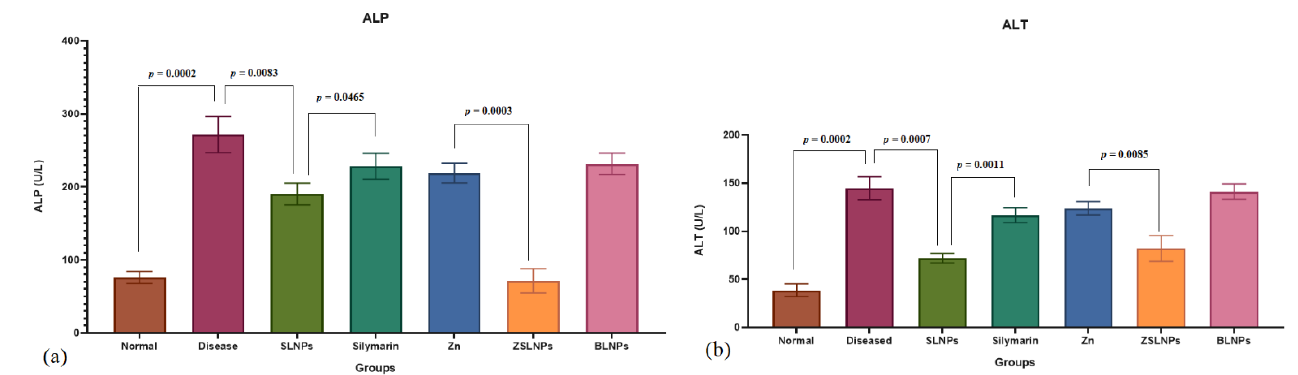
Figure 10. Mean liver function test results of rats ( n = 5) ( a ) ALP and ( b ) ALT, and statistical significance between groups using independent t -test, after sacrifice following the different treatments for a period of 21 days through gavage: diseased, SLNPs (500 µg/kg BW), silymarin (10 mg/kg BW), Zn (10 mg/kg BW), ZSLNPs (10 mg/kg BW + 500 µg/kg BW), and BLNPs (500 µg/kg BW).